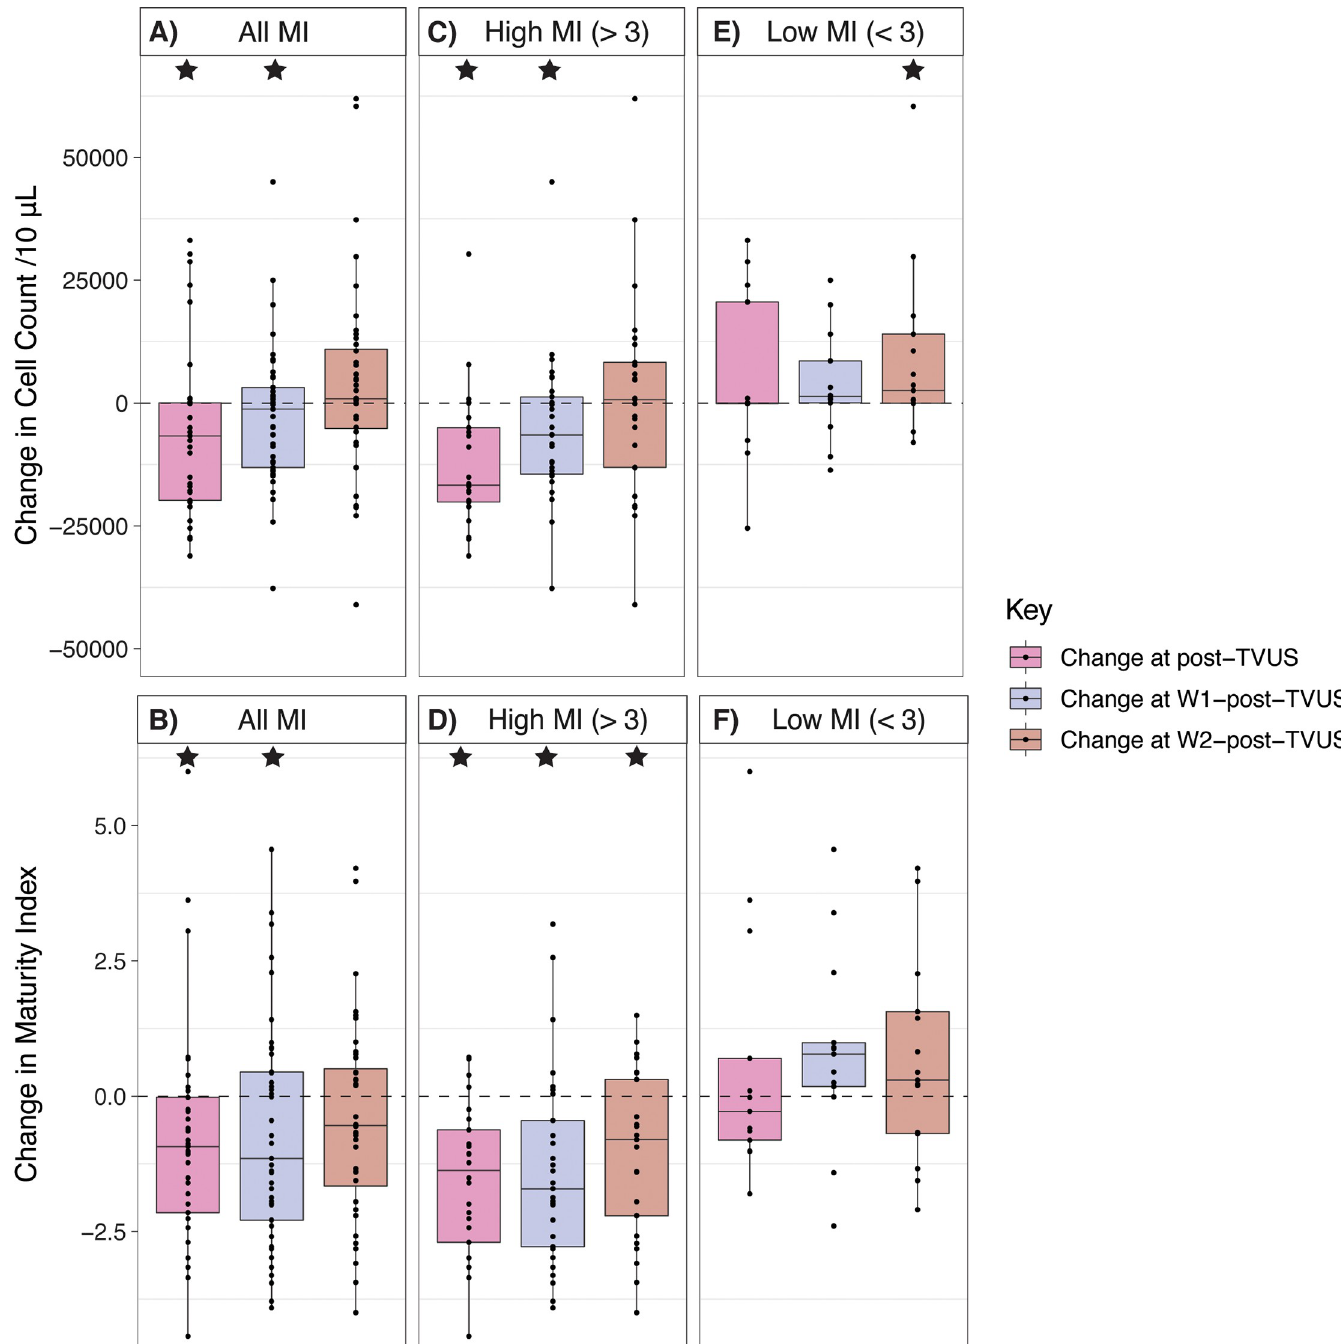
Fig 2. Dashed lines represent change = 0. Stars represent significant pairwise differences from pre-TVUS samples. A. For all participants, the change in VE cell count per 10 μ L CVF in samples taken approximately 12 hours later (post-TVUS), within one week (W1-post-TVUS), and within two weeks (W2-post-TVUS), compared to immediately before TVUS. B. For all participants, the change in maturity index (MI) of samples taken approximately 12 hours later (post-TVUS), within one week (W1-post-TVUS), and within two weeks (W2-post-TVUS), compared to immediately before TVUS. C. For only participants with a pre-TVUS MI > 3, the change in VE cell count per 10 μ L CVF in samples approximately 12 hours later (post-TVUS), within one week (W1-post-TVUS), and within two weeks (W2-post-TVUS), compared to immediately before TVUS. D. For only participants with a pre-TVUS MI > 3, the change in maturity index (MI) of samples taken approximately 12 hours later (post- TVUS), within one week (W1-post-TVUS), and within two weeks (W2-post-TVUS), compared to immediately before TVUS. E. For only participants with a pre-TVUS MI < 3, the change in VE cell count per 10 μ L CVF in samples taken approximately 12 hours later (post-TVUS), within one week (W1-post-TVUS), and within two weeks (W2-post-TVUS), compared to immediately before TVUS. F. For only participants with a pre-TVUS MI < 3, the change in maturity index (MI) of samples taken approximately 12 hours later (post-TVUS), within one week (W1-post-TVUS), and within two weeks (W2-post-TVUS), compared to immediately before TVUS. https://doi.org/10.1371/journal.pone.0250153.g002 PLOS ONE | https://doi.org/10.1371/journal.pone.0250153 May 3,